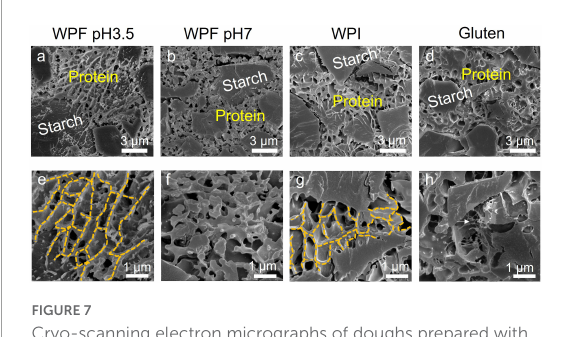
FIGURE7 Cryo-scanning electron micrographs of doughs prepared with different proteins. (a,e) Whey protein fibril at pH 3.5 (WPF pH3.5). (b,f) Whey protein fibril at pH 7 (WPF pH7). (c,g) Native whey protein isolate (WPI). (d,h) Gluten. Protein and starch in the doughs are labeled with yellow and white texts, respectively. The yellow dashed lines in (e,g) represented the network structure formed within WPF pH3.5 and WPI areas. The white arrow in (h) highlighted the gluten